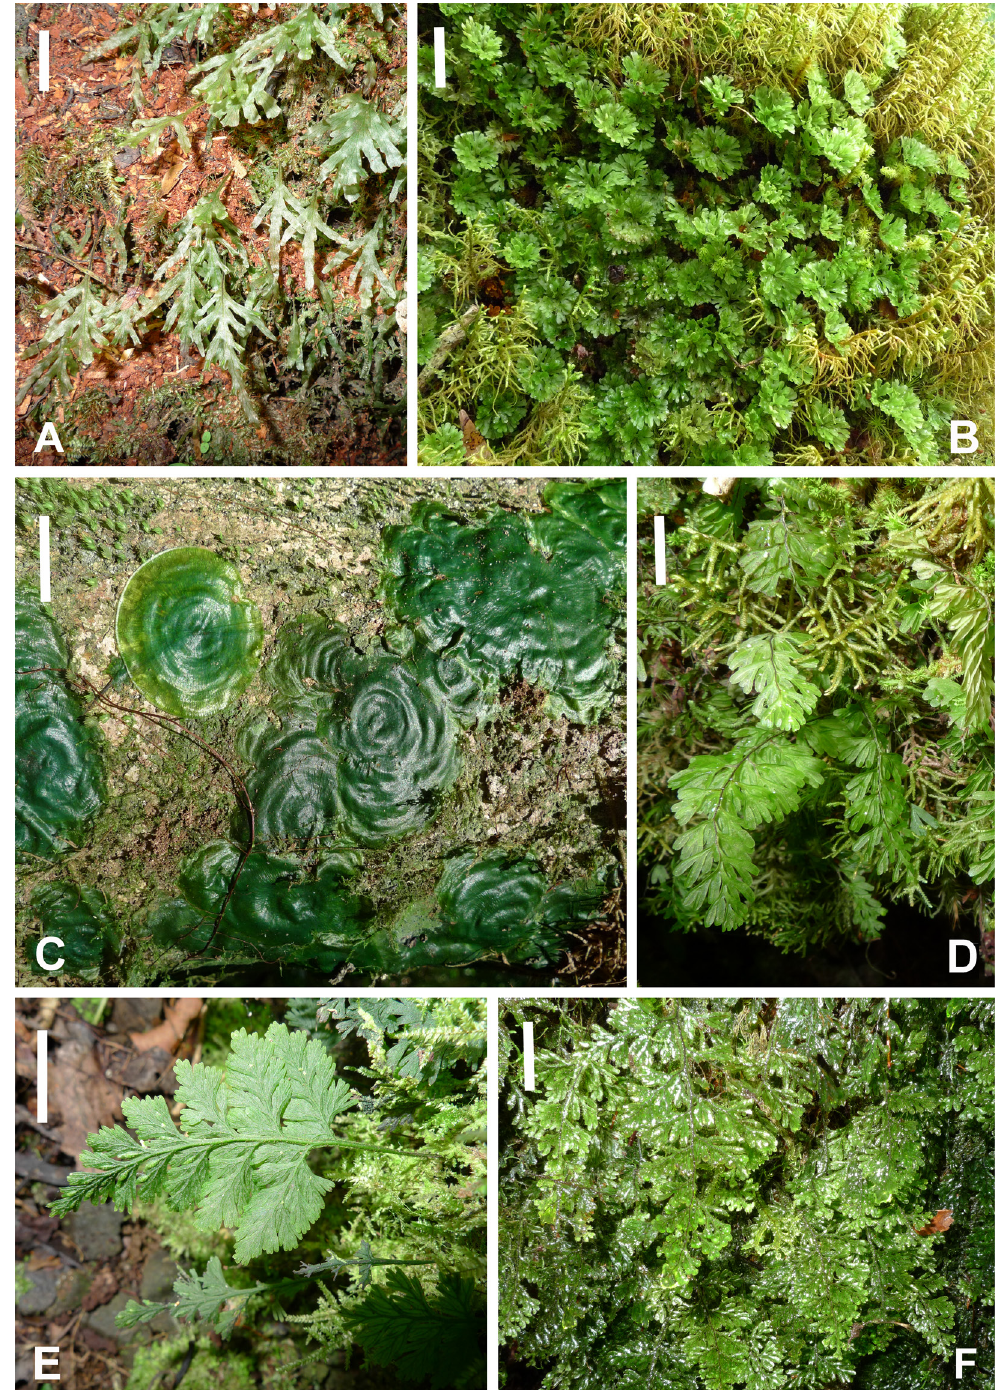
Fig. 3. Representative Comorian Hymenophyllaceae as observed in situ in rainforests (here from Grande Comore or Mohéli). A . Endemic Didymoglossum kirkii (Hook.) Ebihara & Dubuisson ( G.Rouhan et al. 925 , P00684886). B . Hymenophyllum sibthorpioides (Bory ex Willd.) Mett. ex Kuhn ( G.Rouhan et al. 888 , P02439806). C . Didymoglossum hildebrandtii (Kuhn) Ebihara & Dubuisson ( M.Pignal et al. 3456 , P02439793). D . Hymenophyllum kuhnii C.Chr. ( G.Rouhan 897 , P02439807). E . Crepidomanes bipunctatum (Poir.) Copel. ( G.Rouhan et al. 882 , P02439805). F . Hymenophyllum hirsutum (L.) Sw. ( M.Pignal et al. 3487 , P02439796). Photographs by G. Rouhan. Scale bars = 1